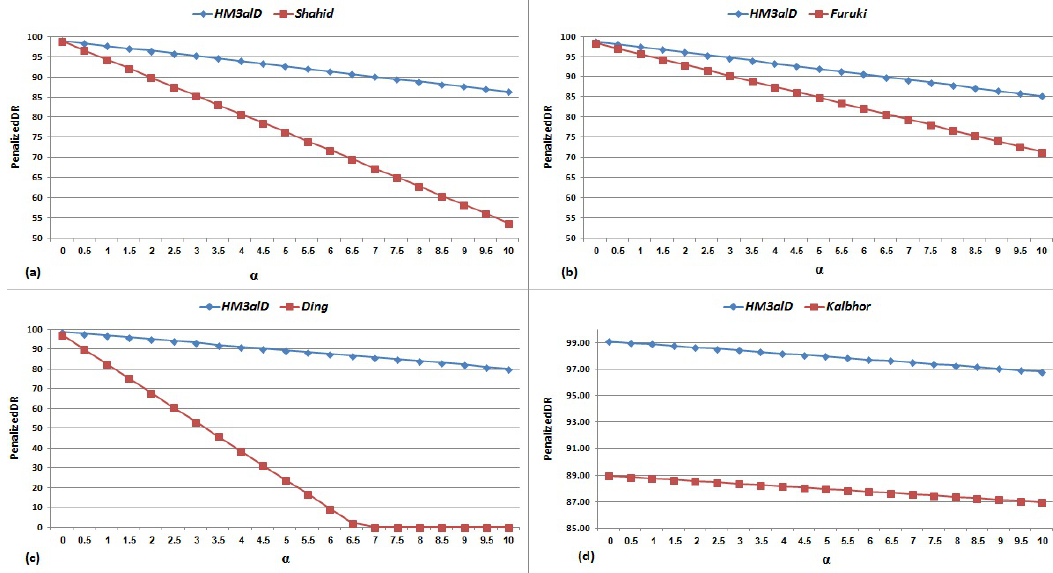
Figure 11. PenalizedDR for HM 3 alD and current static methods: ( a ) Shahid (2015) [5]; ( b ) Furuki (2012) [12]; ( c ) Ding (2013) [17]; and ( d ) Kalbhor (2015) [13]. Note that we estimated FAR value of Ding work [17] from DR and